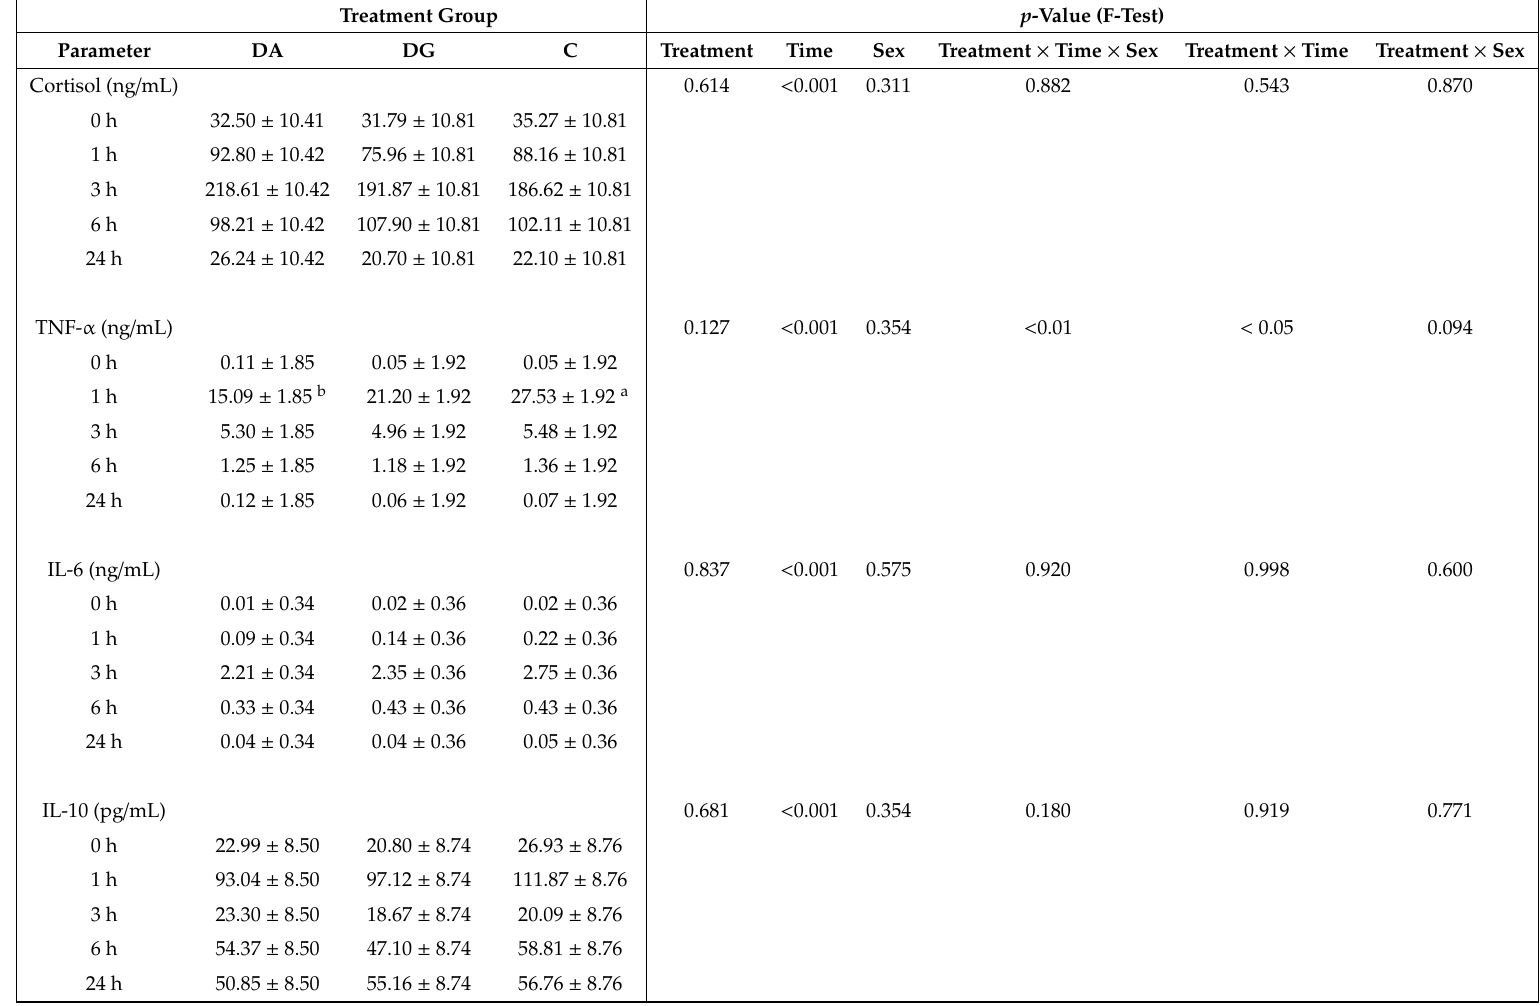
Table 2. Endocrine and immune parameters in piglets of di ff erent treatment